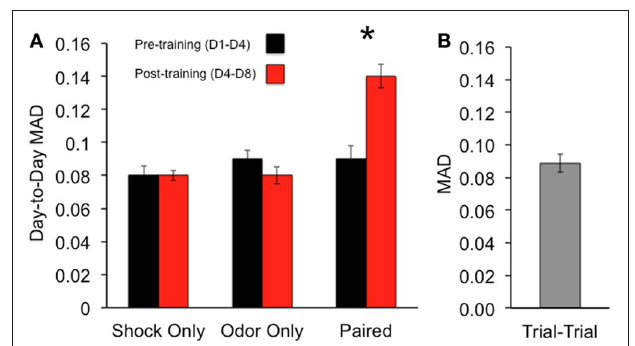
FIGURE 6 | Percentage of glomeruli displaying large post-training absolute changes in response amplitude for each group. Associative conditioning leads to a larger percentage of strongly altered ( > 25% D4–D8 change) glomeruli than the control groups. Glomeruli were pooled from all mice in each group ( n = 327). Error bars represent